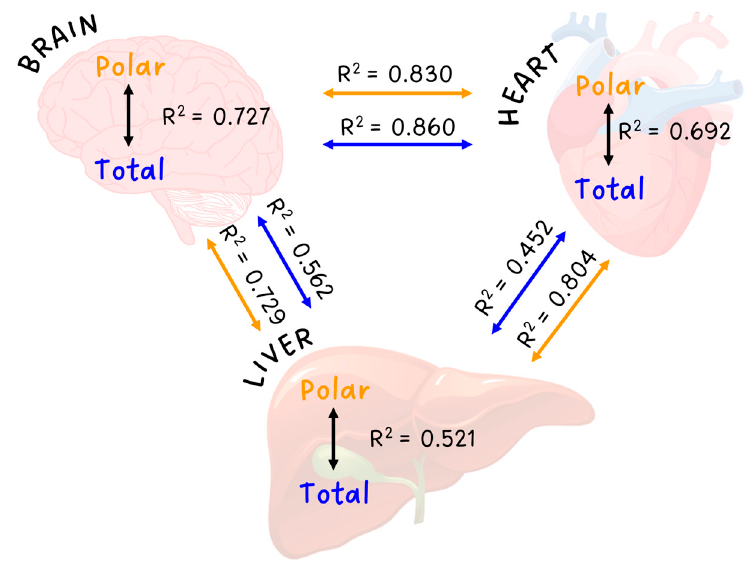
Figure 9. Intra- (total-polar) and inter-tissue correlations based on permeability measurement (n = 3). Determination coefficients are derived from paired linear regressions.